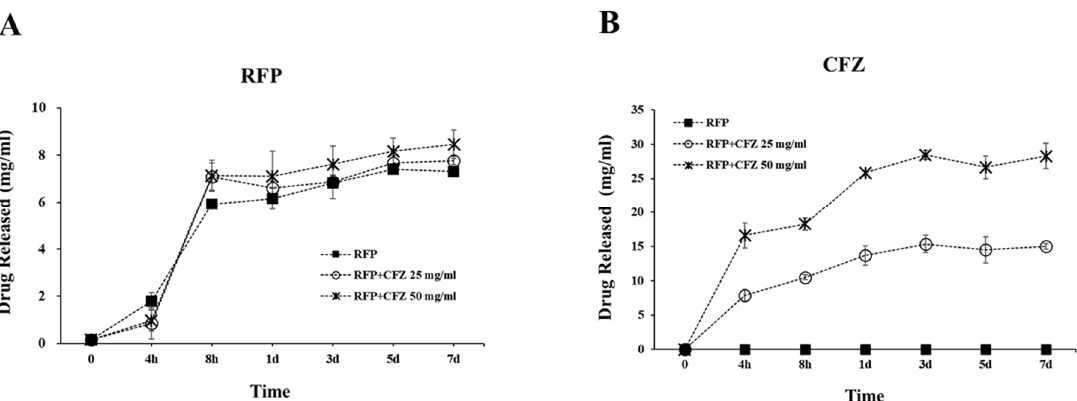
Figure 2. Cumulative drug release concentrations for the release of ( A ) RFP and ( B ) CFZ in PBS media. The drug release study was performed in PBS (pH 7.4), and the amount of drug release was estimated by HPLC analysis. RFP: rifampicin; CFZ: cefazolin .